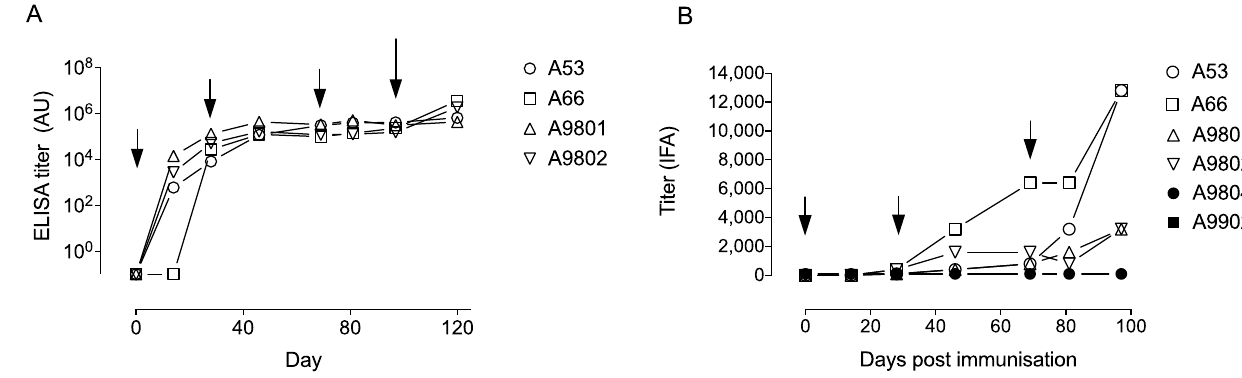
Figure 2. A. Antigen specific antibody titers of sera from Aotus monkeys immunized with the GST-FVO Block 2 fusion protein. Serum samples collected at the time points listed in Table 2 were tested for reactivity with cleaved, purified FVO MSP-1 Block 2. Small arrows indicate immunization time points. Large arrow indicates P. falciparum challenge time point. Titers were calculated by interpolation from titration curves for each serum sample, with the endpoint titer defined as the dilution that gave an optical density value of 0.1. B. Parasite-reactive antibody titers of sera from four immunized Aotus (A53, A66, A9801, A9802) plus control animals (A9804, A9902). Sera were tested by IFA against the Wellcome P. falciparum strain (which has an identical MSP-1 Block 2 sequence to FVO). Hollow symbols, immunized animals; filled symbols, control (non-immunized) animals. Small arrows indicate immunization time points. doi:10.1371/journal.pone.0083704.g002 PLOS ONE |